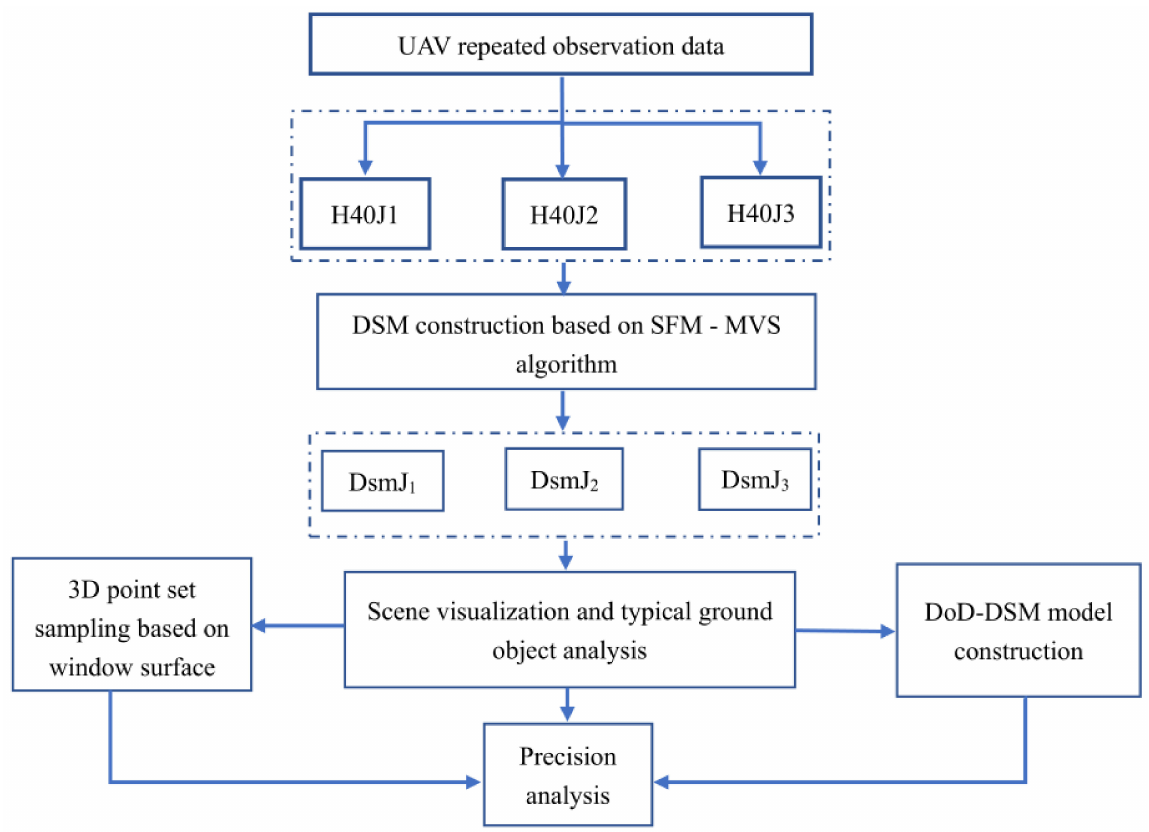
Figure 2. Flow chart of technical